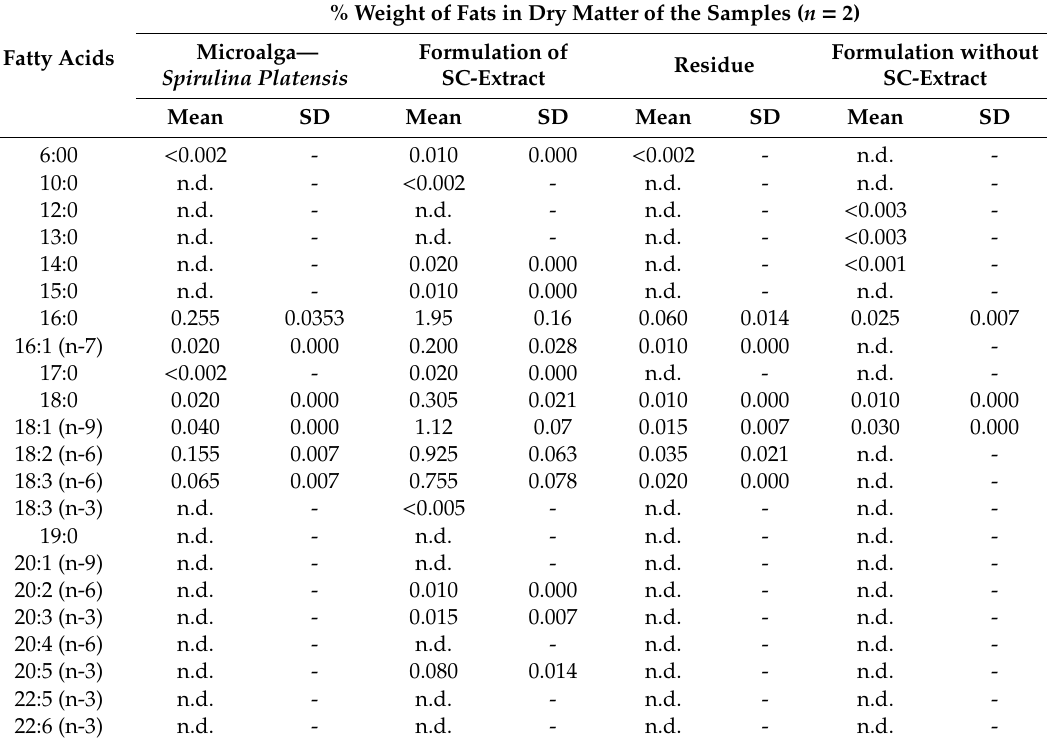
Table 3. Percentage weight of FAs in the samples used in laying hens feeding. % Weight of Fats in Dry Matter of the Samples ( n = 2) Formulation Formulation of Fatty Acids Residue Spirulina Platensis SC-Extract